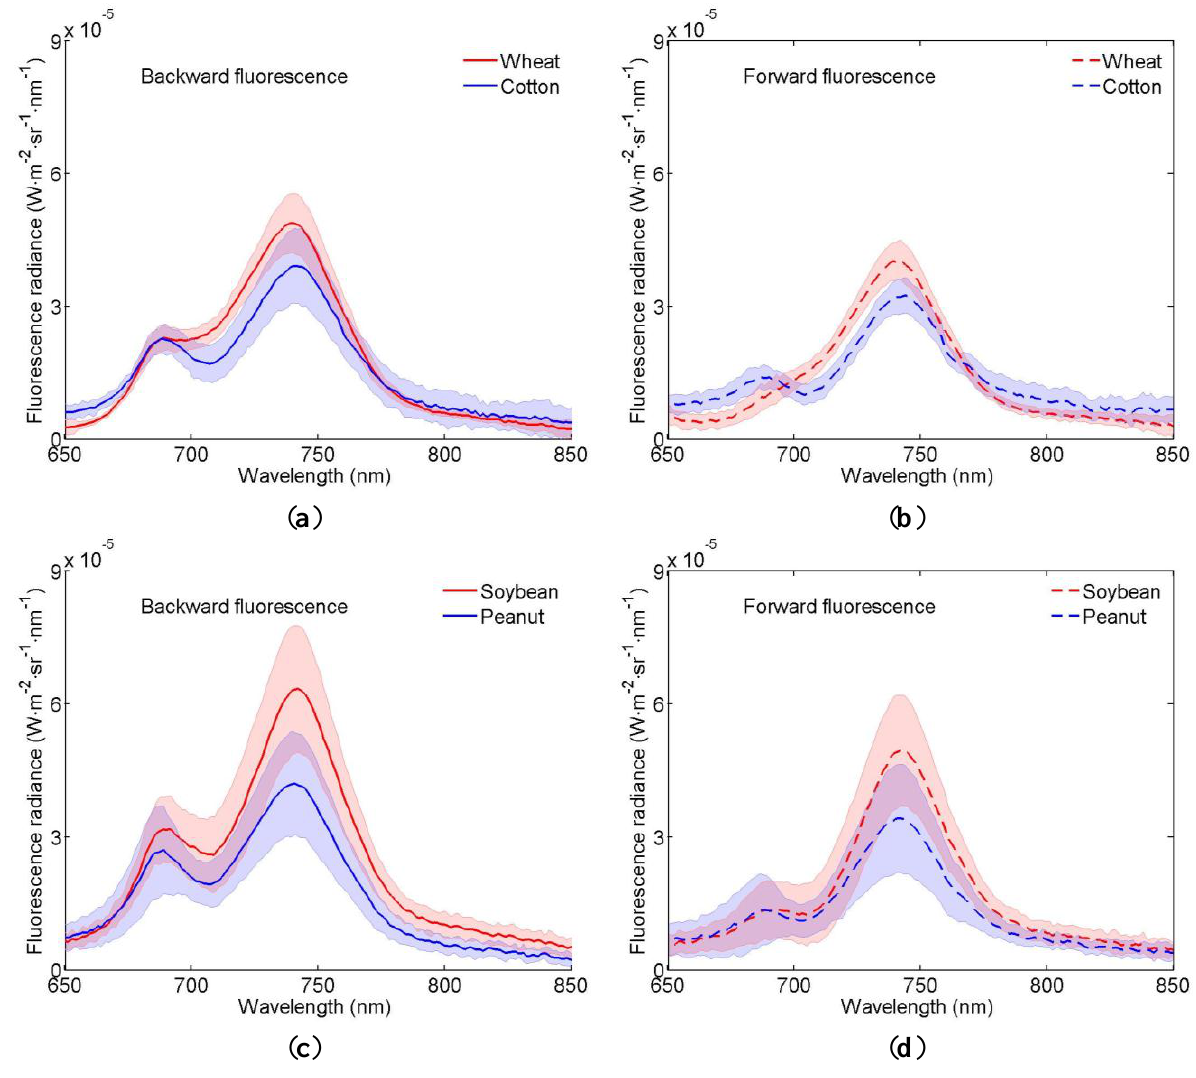
Figure 5. The mean fluorescence spectra measured in the experiments. ( a ) The backward fluorescence spectra for wheat and cotton leaves; ( b ) The forward fluorescence spectra for wheat and cotton leaves; ( c ) The backward fluorescence spectra for soybean and peanut leaves; ( d ) The forward fluorescence spectra for soybean and peanut leaves. The shaded portions represent standard deviation of the measured